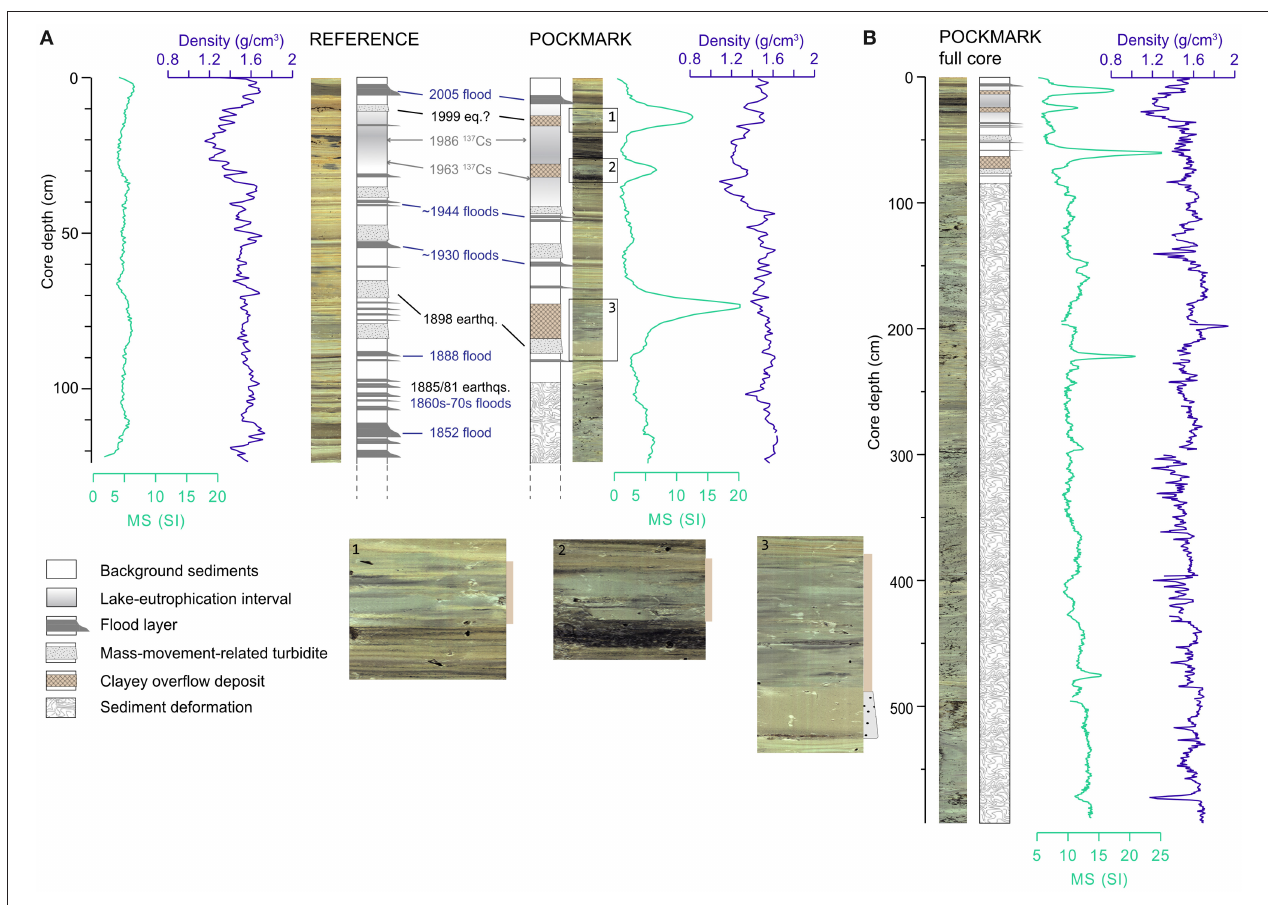
FIGURE 3 | Sediment description of the pockmark and reference core of the BPS including photographs and lithology correlated with the magnetic susceptibility (MS) and density of (A) the uppermost 120cm of the reference and pockmark cores, and (B) the full Kullenberg core taken inside the pockmark. 137 Cs dating and the flood-layer chronology in (A) is based on Wirth et al.